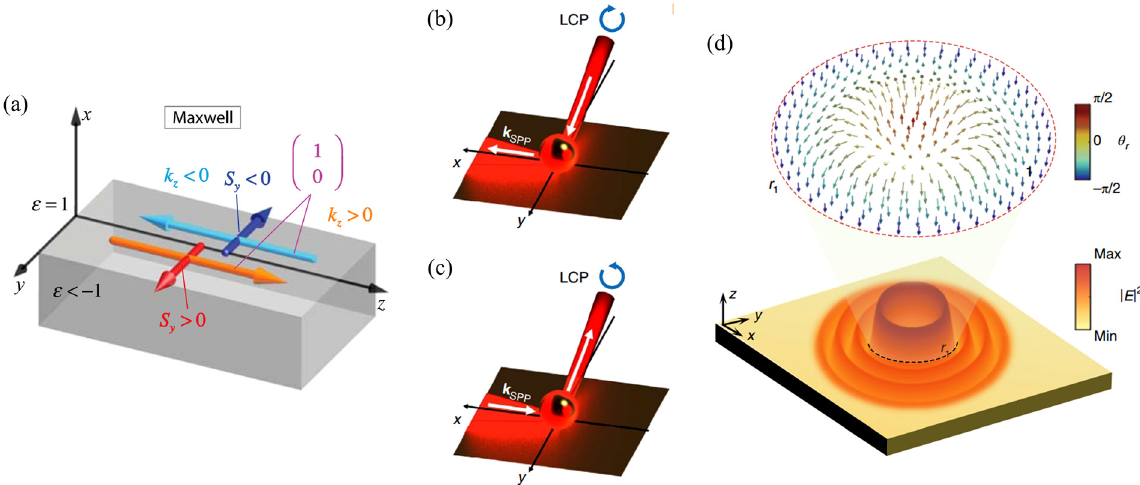
Figure 2: Optical phenomena associated with transverse spin: (a) optical analog of the quantum spin-Hall effect in a single polarized evanescent plane wave, for which the transverse spin vector is strictly locked to the direction of momentum [67]; (b) helix-controlled unidirectional emission of surface mode arising from the spin – momentum locking of t -SAM [62]; (c) the inversed effect of (b): direction- dependent excitation of helical modes [62]; and (d) photonic spin skyrmion formed in a single polarized evanescent optical vortex through spin – orbit coupling